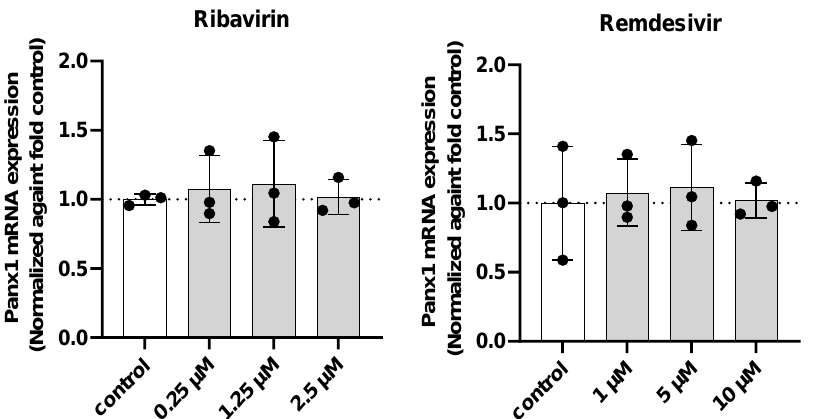
Figure 4. Panx1 mRNA expression after 24 h exposure of transduced Dubca cells overexpressing human Panx1 to the drug panel. mRNA expression levels were measured using RT-qPCR analysis. Data were analysed using the Pfaffl method in qbase+ and normalised using ubiquitin C as a housekeeping gene. Results were relatively expressed against the respective controls. Statistical analysis was performed with a parametric one-way ANOVA, followed by a Dunnett’s test. Dots represent the respective biological replicates ( N ). Data are expressed as mean ± standard deviation ( N = 3, n = 3) and visualised in separate graphs per drug.